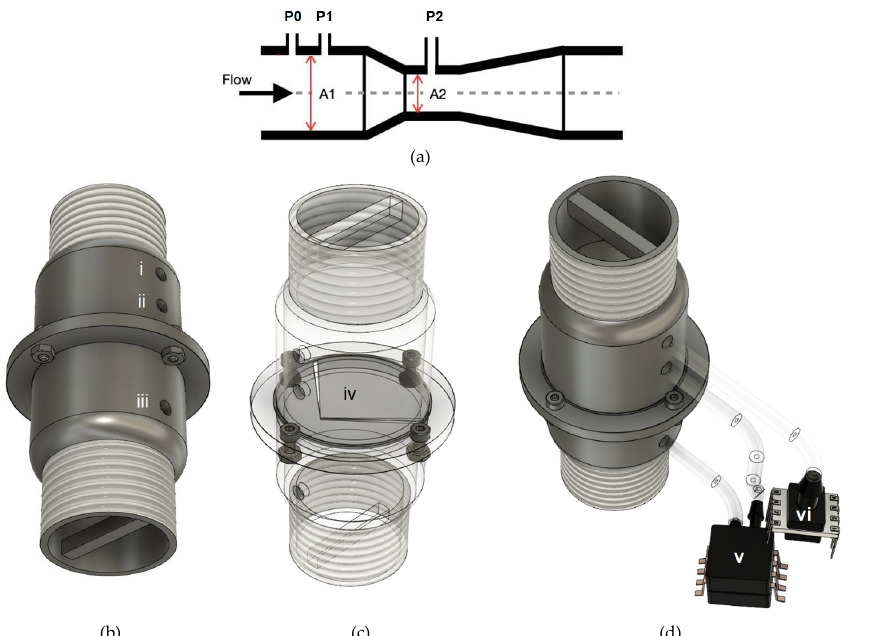
Figure 2. Integrated flow and pressure sensor: ( a ) Venturi principle; ( b ) designed integrated flow and pressure sensor where (i) is for pressure sensor, (ii) and (iii) for flow sensor; ( c ) see-through designed integrated flow and pressure sensor where (iv) is air-directing plate to prevent turbulent flow; and ( d ) designed integrated flow and pressure sensor connected with differential pressure sensor (v) for flow sensing and absolute pressure sensor (vi) for pressure sensing.